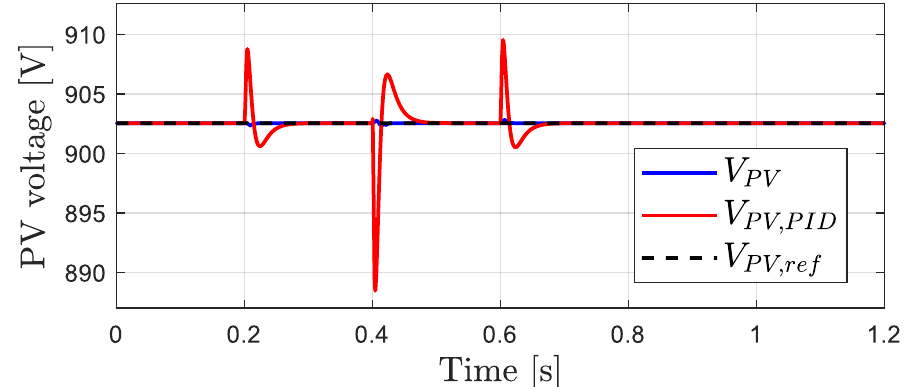
Figure 17. PV voltage time profile comparison.